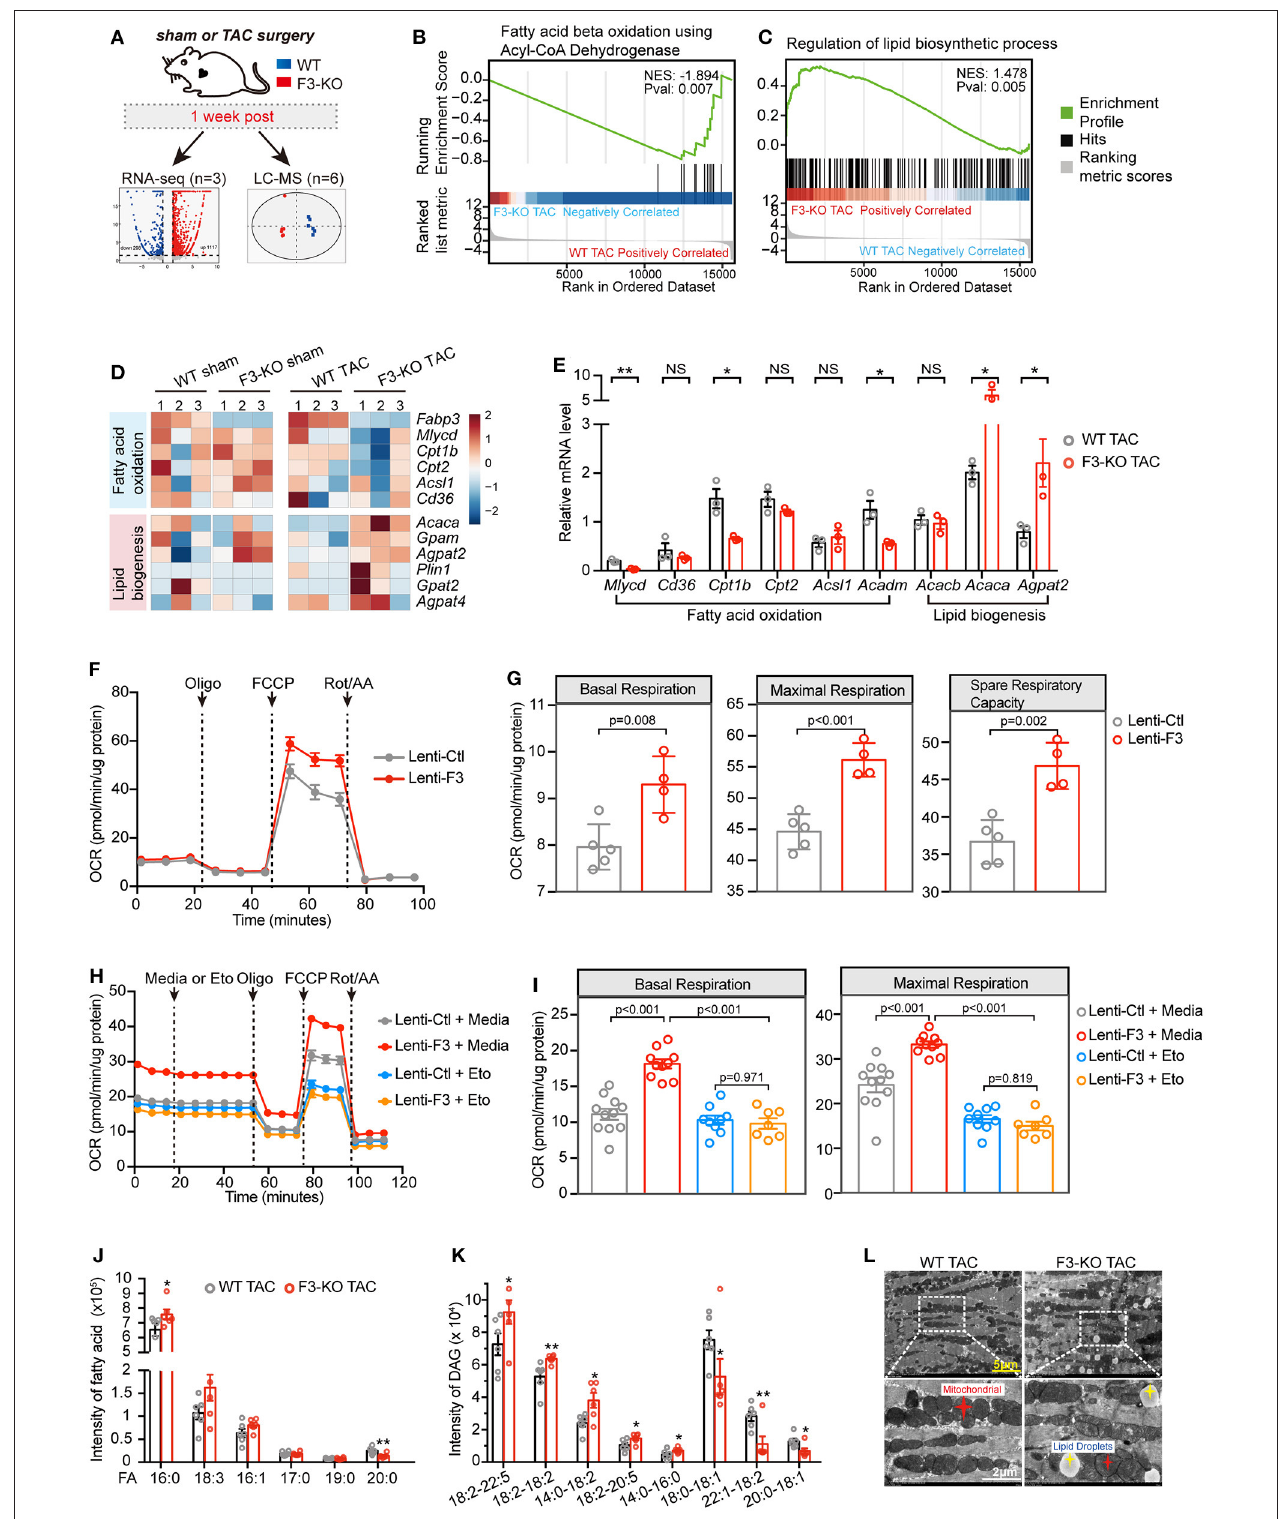
FIGURE 4 | FABP3-defect results to compromised fatty acid oxidation (FAO) and toxic lipid accumulation. (A) Experimental schematic of RNA-seq analysis and metabolomics analysis in WT and F3-KO hearts. (B,C) GSEA revealing that F3-KO negatively correlates with fatty acid beta oxidation using acyl-CoA